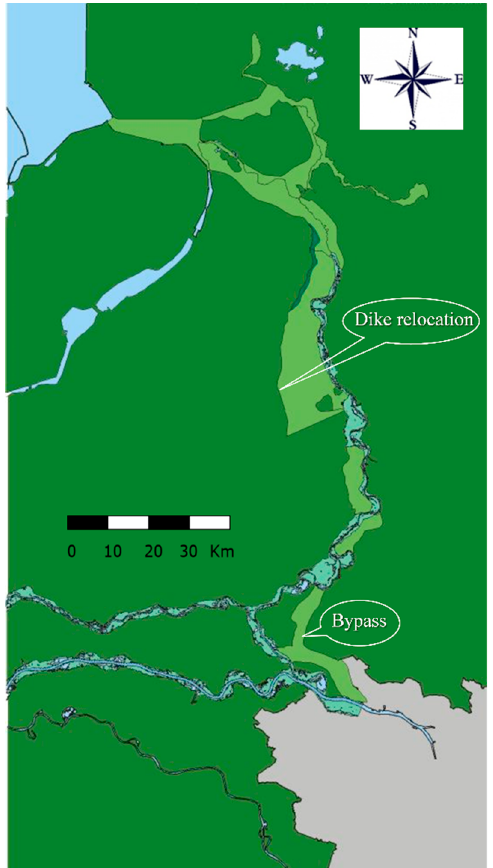
Figure 7. Bypass to the IJssel River and redevelopment of the IJssel (copyright [10]).